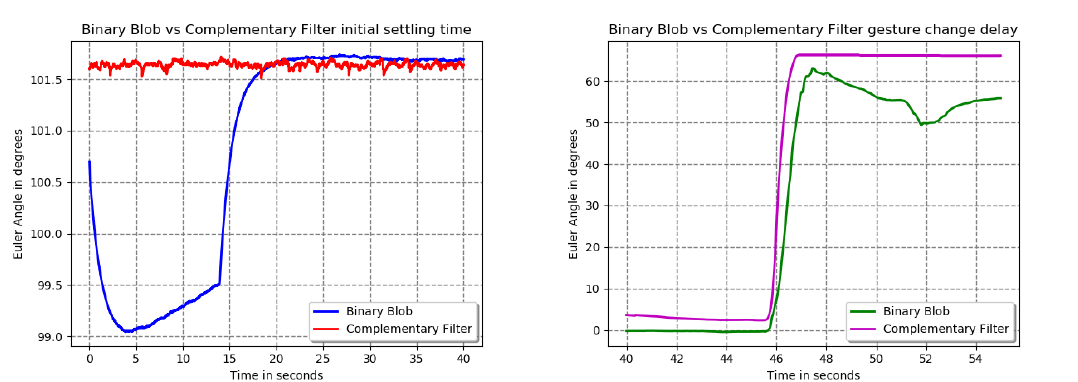
Figure 8. ( Left ): The Complementary Filter instantaneously provides a stable signal, whereas the Binary Blob needs up to 20 s settle time. ( Right ): The Complementary Filter reacts faster to a gesture change than the Binary Blob and returns more stable